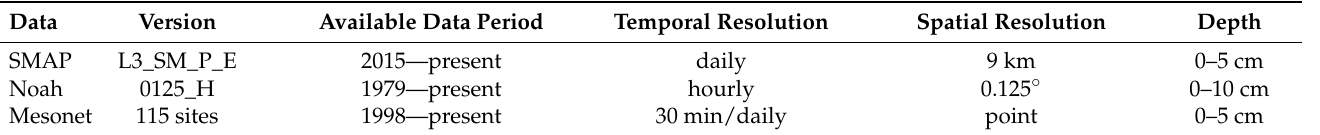
Table 1. Summary metadata of satellite (SMAP L3_SM_P_E herein called SMAP), model (NLDAS_NOAH0125_H herein called Noah), and in situ (Oklahoma Mesonet) soil moisture products used in this study.